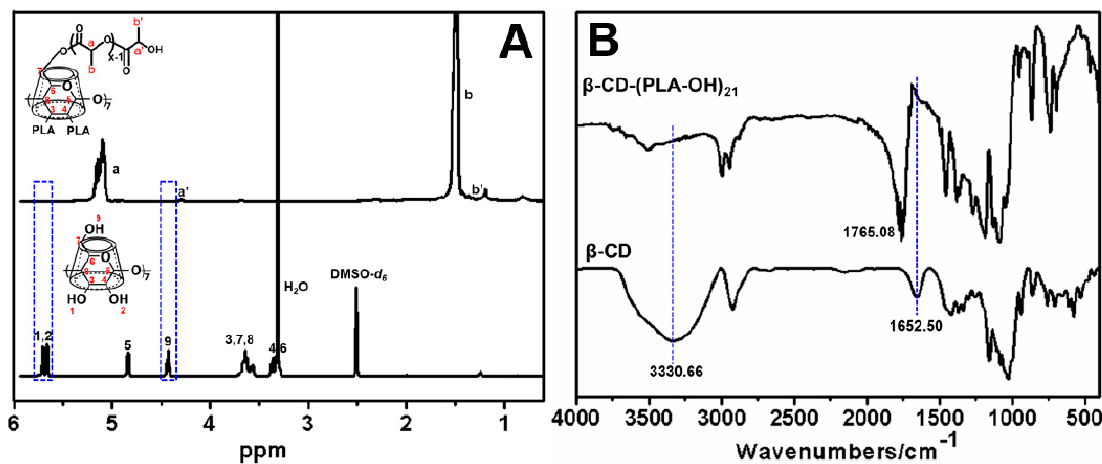
Figure 1. The complete conversion of 21 hydroxyl groups of pristine β -CD to PLA arms. ( A ) 1 H NMR spectra of β -CD in DMSO- d 6 and β -CD-(PCL-OH) 21 in CDCl 3 ; ( B ) FT IR spectra of β -CD and β -CD-(PCL-OH) 21 .